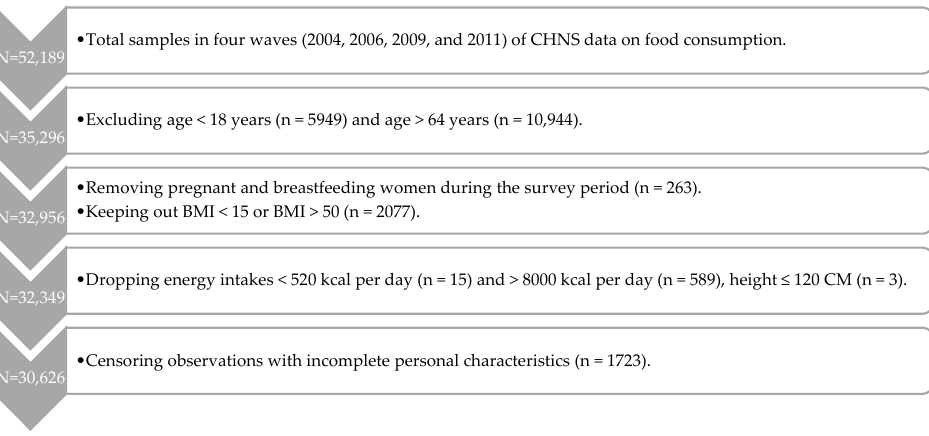
Figure 1 . The process of sample selection. Figure 1. The process of sample